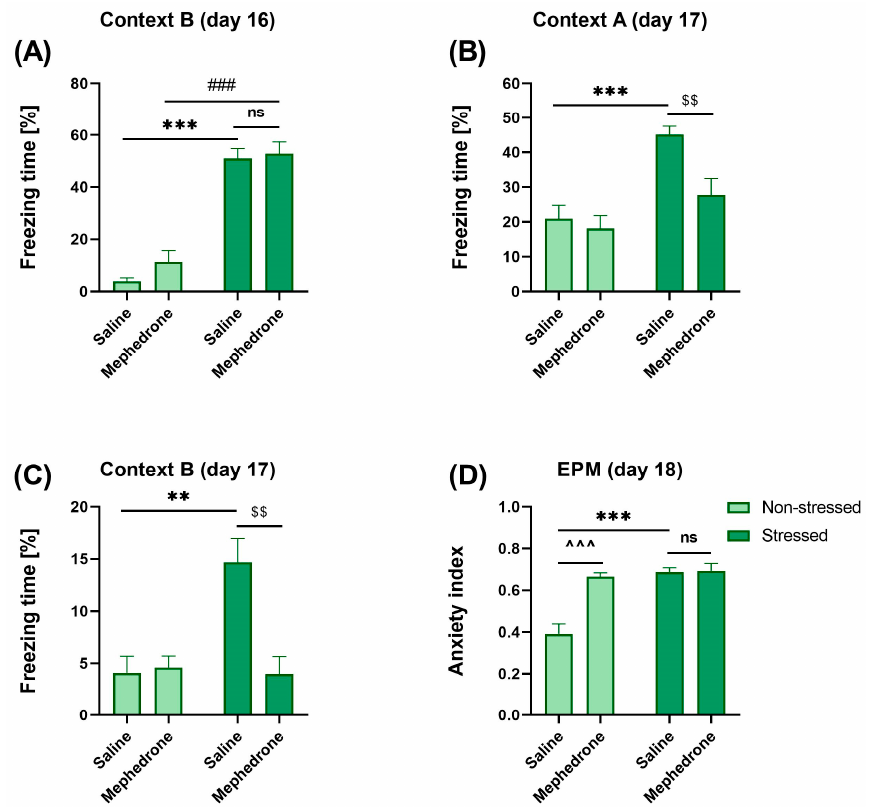
Figure 3. Impact of repeated mephedrone (5 mg/kg) injections on fear conditioning (PTSD ‐ like syndrome) in adolescent rats: ( A ) sensitization of freezing behavior in context B (day 16); ( B )